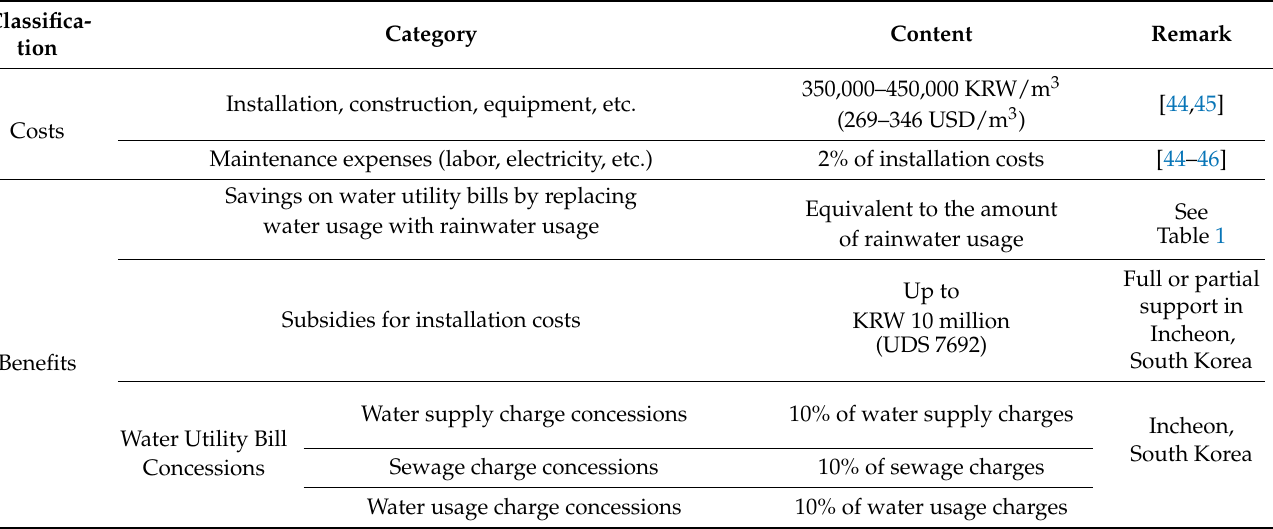
Table 3. The costs and benefits of the installation and operation of a rainwater harvesting system (USD 1 = KRW